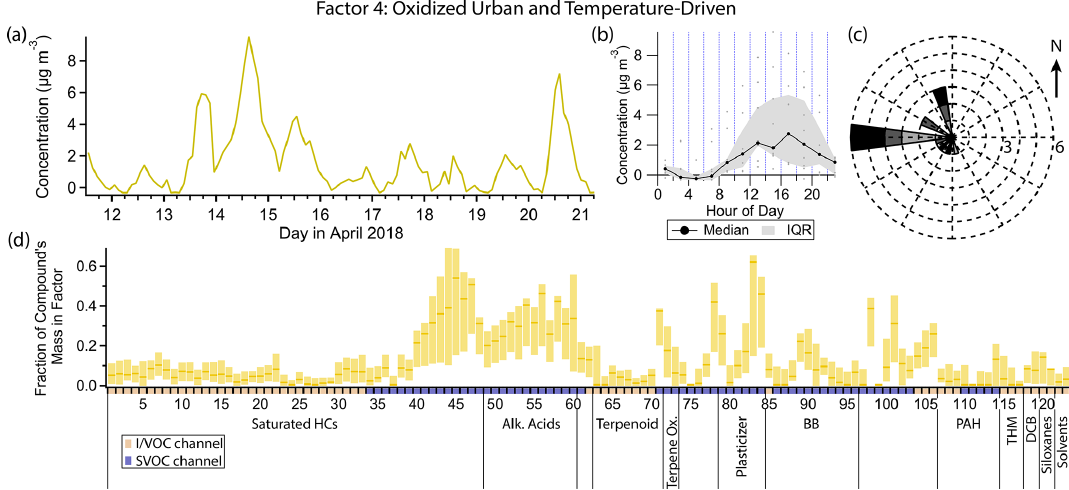
Figure 7. (a) Factor 4 timeline. (b) Diurnal profile for Factor 4. (c) Rose plot showing correlation of elevated emissions and wind direction. (d) Factor 4 composition profile. See Fig. 4 description for further information on how to read this figure.